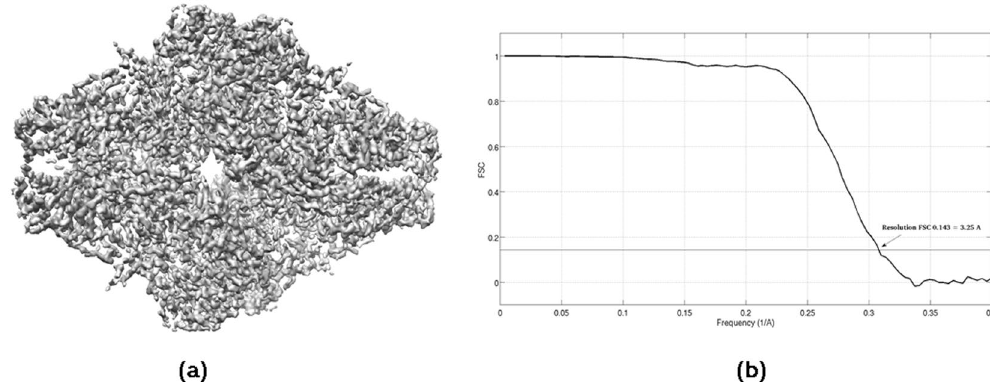
Figure 4. Reconstructed 3DEM map for the β -galactosidase complex of the 2015 Map Challenge with EMPIAR codes EMPIAR-10012 and EMPIAR-10013 ( a ) and obtained FSC curve based on Gold standard approach. The resultant 0.143-FSC resolution is of 3.25 Ǻ.